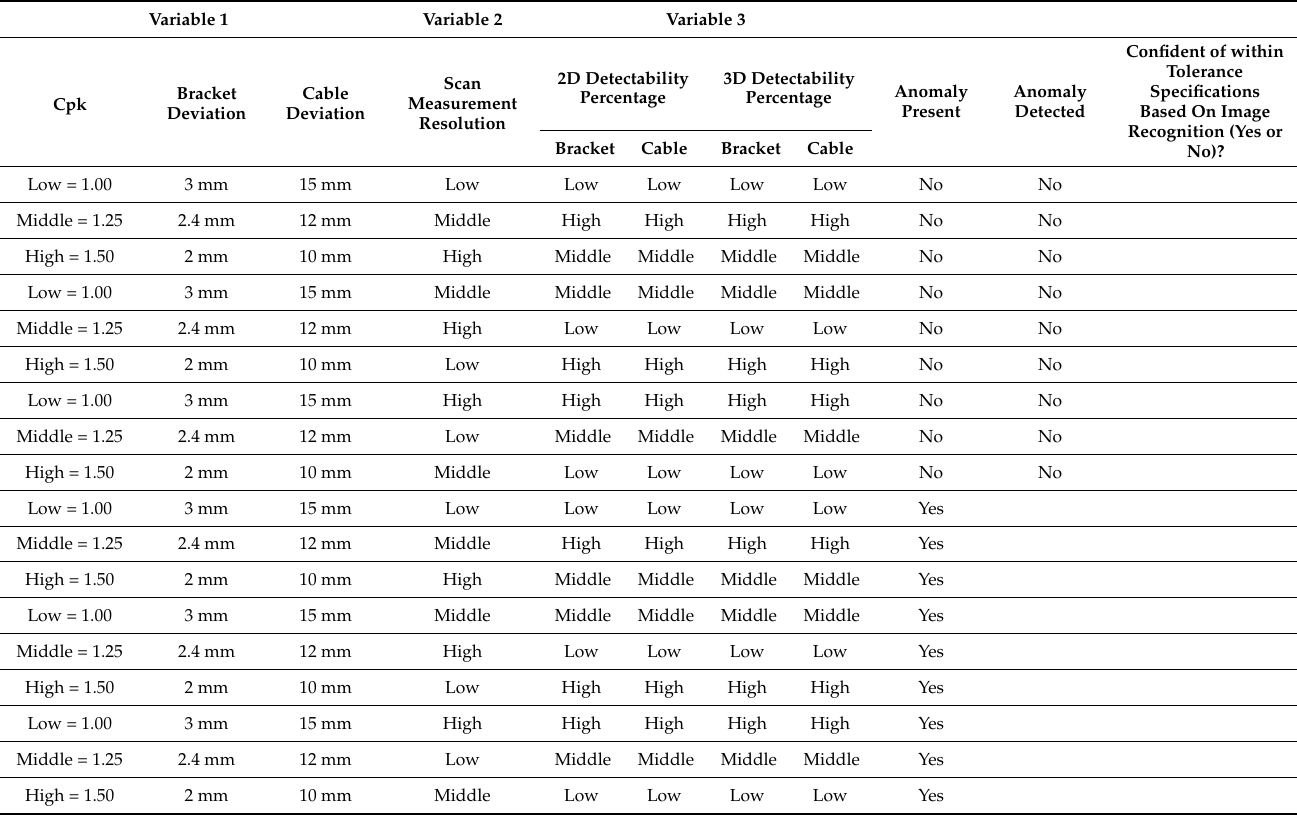
Table 3. Data to be generated by the designed